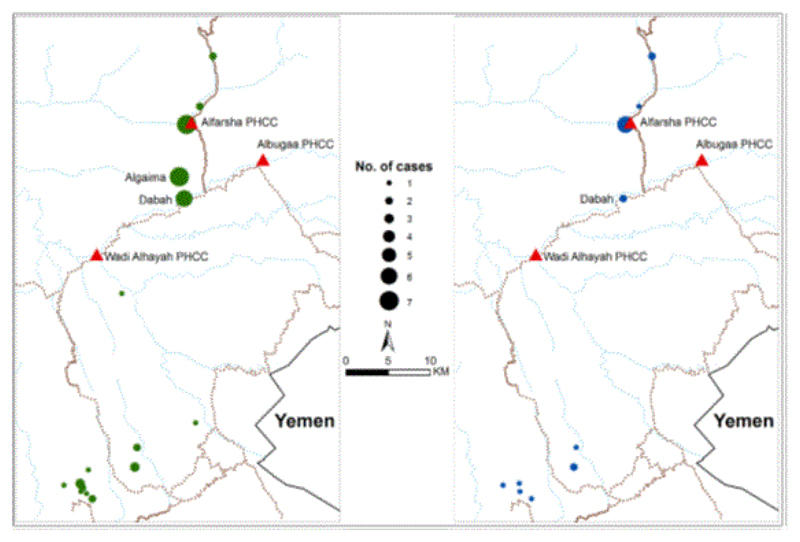
Map showing the location of 49 cases of malaria detected in 2006-2007 Green dots
left hand side and the 18 cases of malaria without history of travel, blue dots
on right hand side.